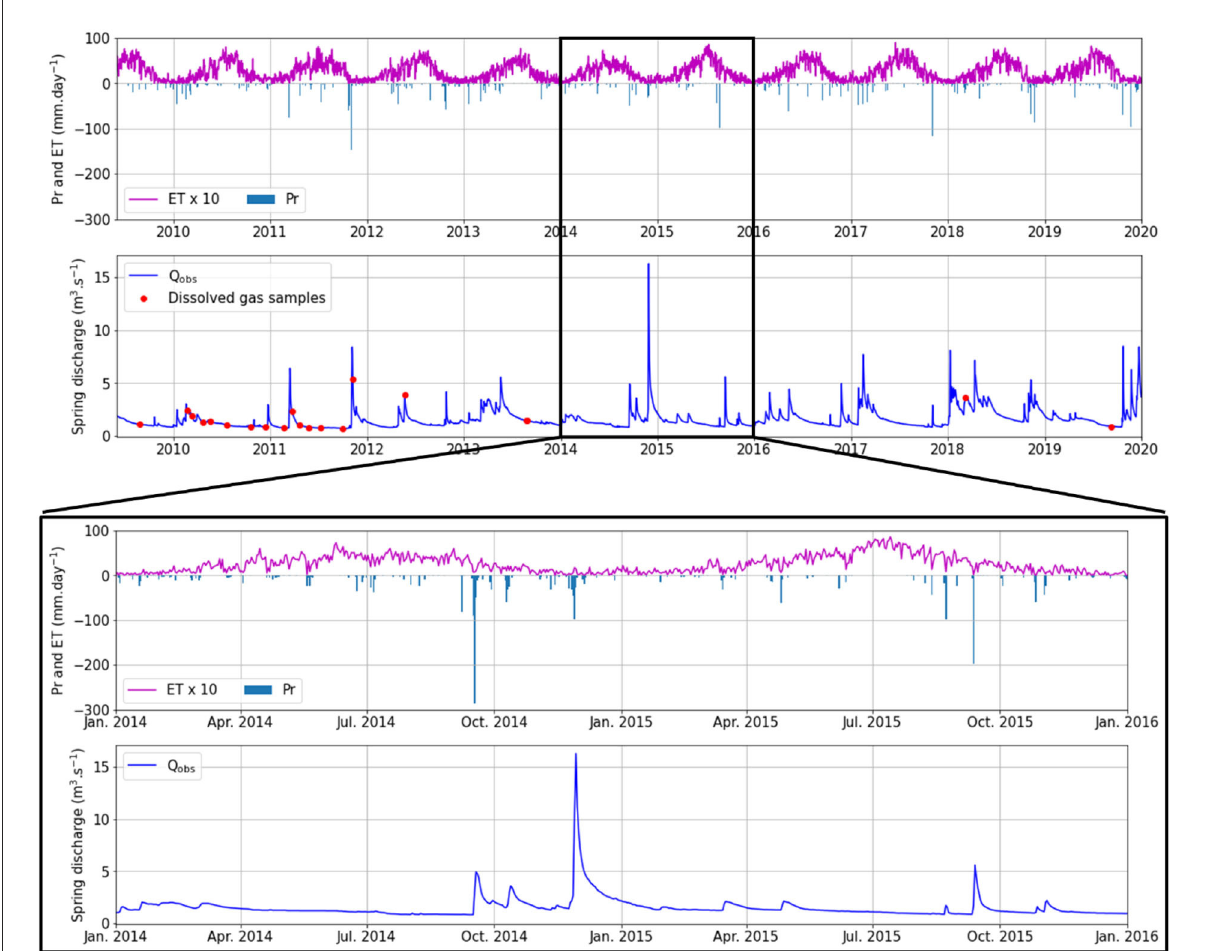
FIGURE2 (Top) Precipitation (Pr) and evapotranspiration (ET) time series measured at the Caylar station and discharge time series measured at the Durzon spring and sampling of dissolved gases–(Bottom) Zoom on the period from 2014 to